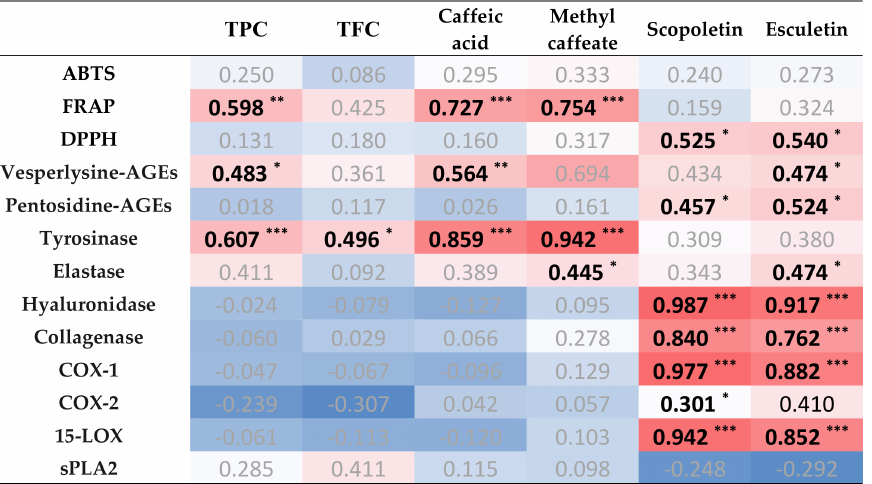
Figure 2. Pearson correlation coefficients (PCCs) linking the phytochemicals and biological activities of extracts from S. virginianum callus cultures. Colors indicate the strengths of the PCC values, with low PCC values in blue and high PCC values in red. Only statistically significant PCC values are in bold. *** significant p < 0.001; ** significant p < 0.01; * significant p <